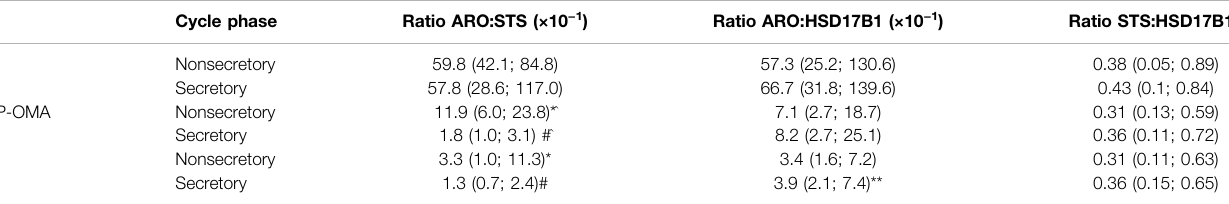
TABLE 2 | Protein expression ratio among ARO , STS , and HSD17B1 in biopsies from endometriotic lesions and from eutopic endometrium of nonendometriosis patients (control). Cycle